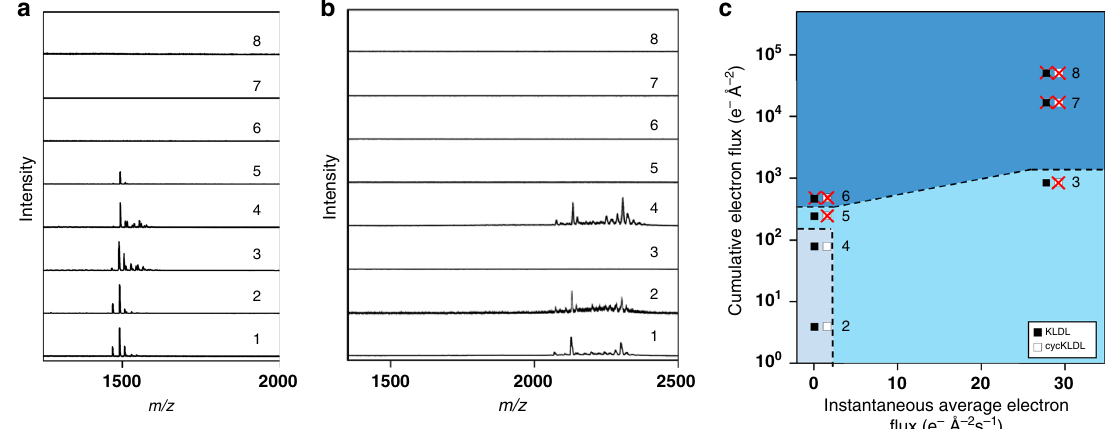
Fig. 6 Establishing electron fl ux and cumulative electron fl ux thresholds for KLDL and cycKLDL. Compilation of a KLDL and b cycKLDL MALDI-IMS spectra acquired in window regions of LCTEM chips after imaging under: Condition 1 (no fl ux); 2 (low fl ux, pulsed, 30 min total); 3 (high fl ux, pulsed, 30 min total); 4 (low fl ux, 10 min continuous); 5 (low fl ux, 30 min continuous); 6 (low fl ux, 60 min continuous); 7 (high fl ux, 10 min continuous); and 8 (high fl ux, 30 min continuous). c Damage plot for peptides, comparing average electron fl ux and cumulative electron fl ux, with side-by-side square boxes indicating KLDL (black boxes) or cycKLDL (white boxes). Red X indicates that the MALDI signal for intact peptide was absent within the window region of the liquid cell as determined by MALDI-IMS. Source data are provided as a Source Data fi